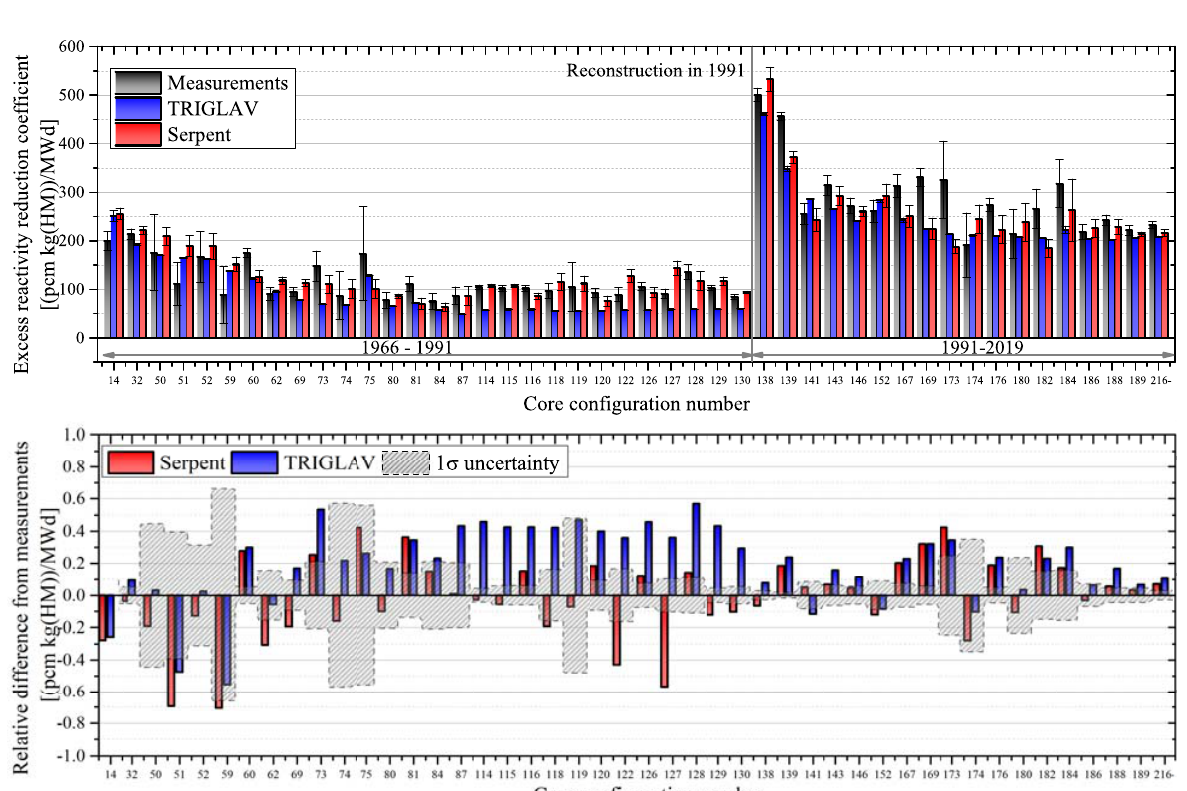
Figure 7: Excess reactivity reduction coefficient for 46 different core configurations (top graph) throughout the JSI TRIGA operational history. Measurements are compared to Serpent-2 and TRIGLAV calculations. Bottom graph presents relative difference between measurements and calculations with its one sigma uncertainty, defined as (cid:3) σ = σ 2 + σ 2 . diff meas . calc .